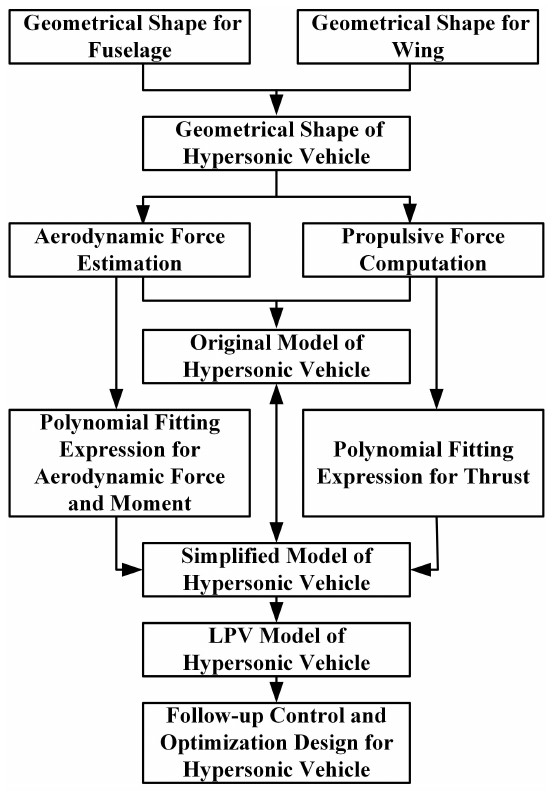
Figure 4. Research course on the simulation